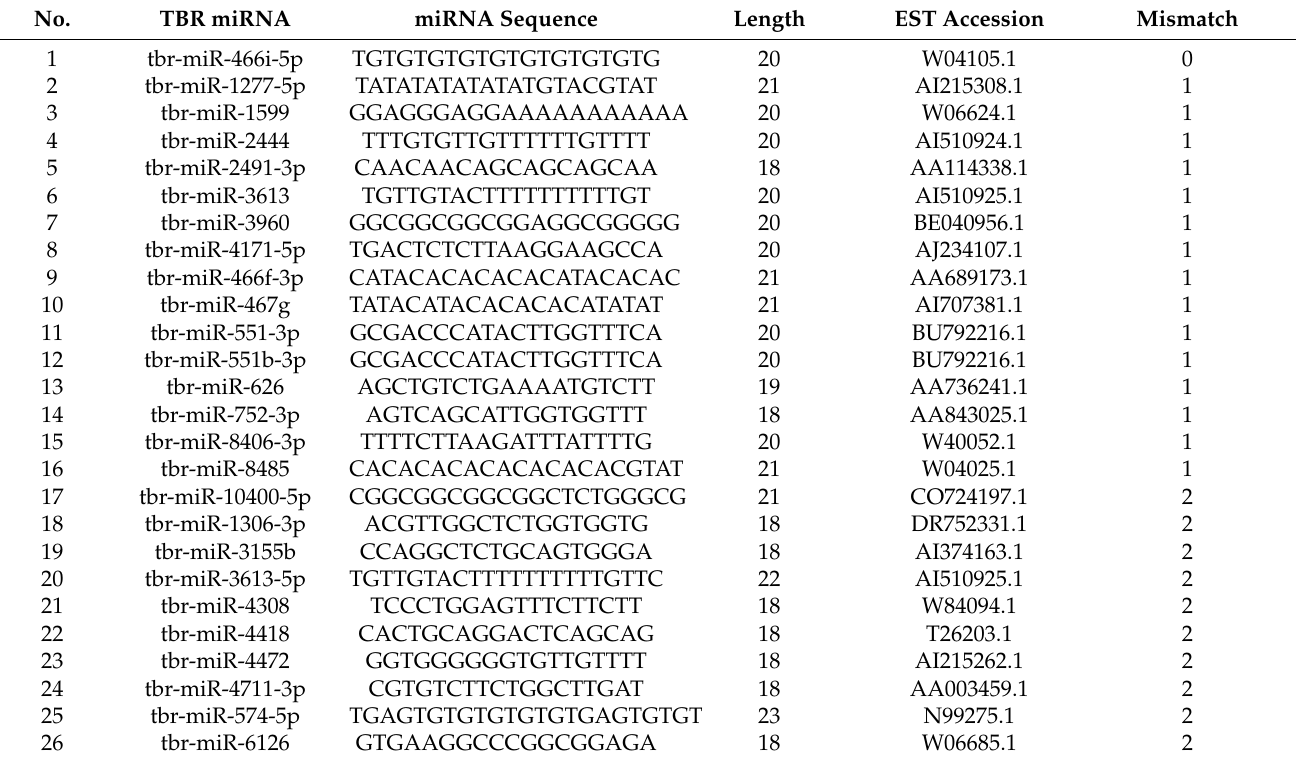
Table 3. Identified novel miRNAs in T. brucei . Most of the sequences are similar to known